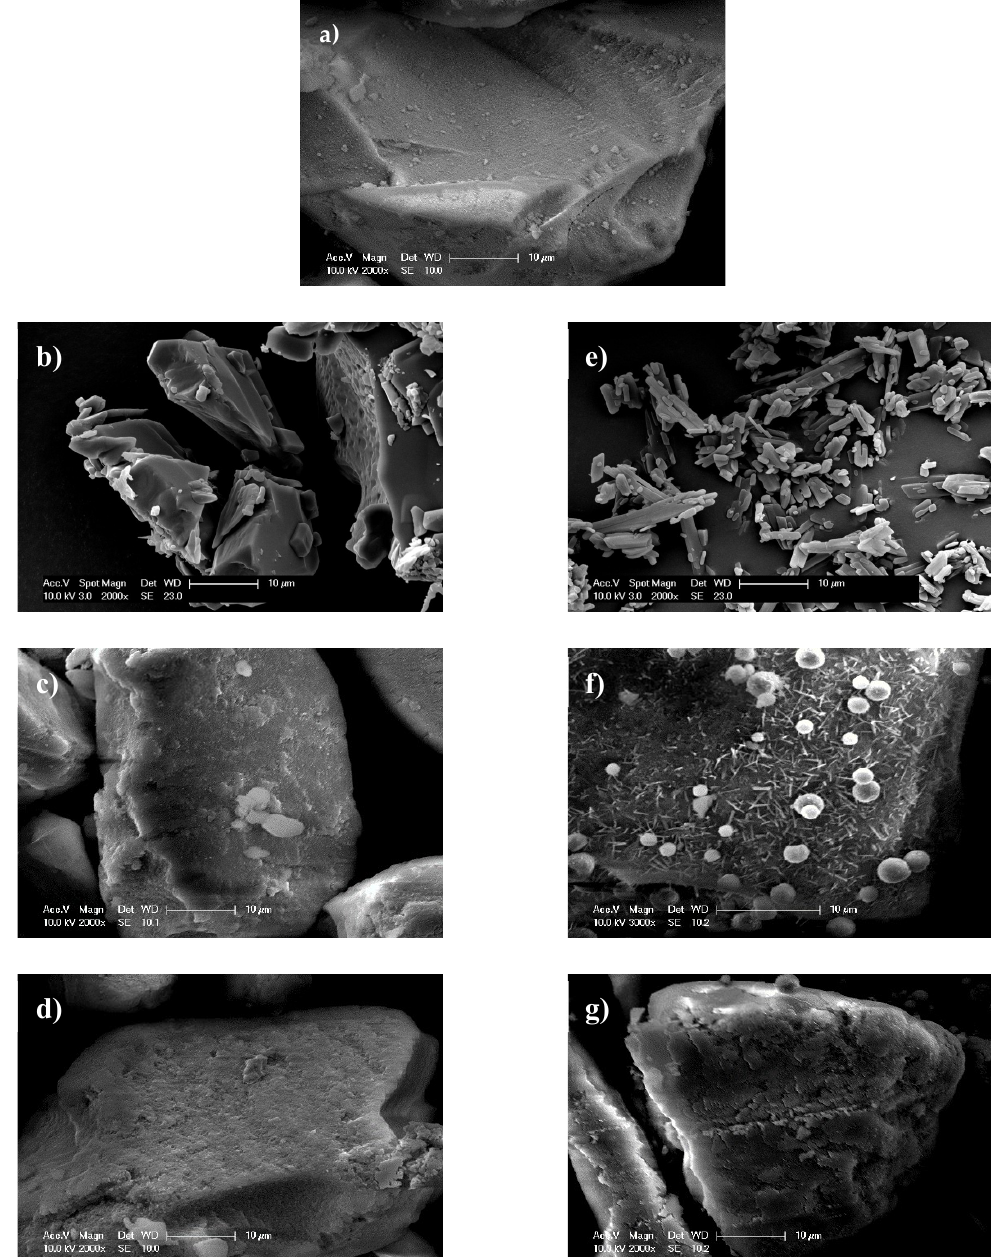
Figure 4. Particle surfaces of ( a ) mesoporous silica Syloid, ( b ) Felodipine raw material, ( c ) FELO-Syloid, ( d ) FELO-Syloid-hypromellose acetate succinate (HPMCAS), ( e ) Furosemide raw material, ( f ) FURO-Syloid, and ( g ) FURO-Syloid-HPMCAS. SEM images were taken for samples at a drug load of 300% surface coverage.